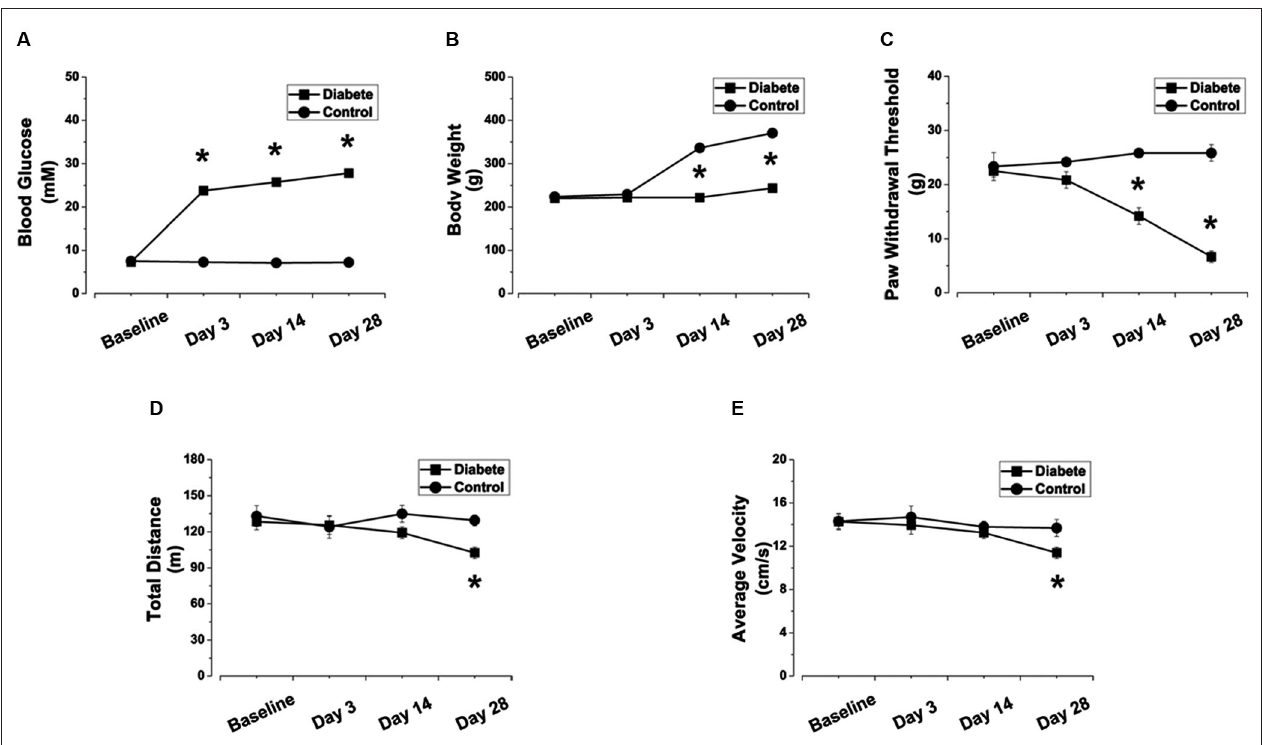
body weight (B) , PWT (C) , total distance (D) and average velocity (E) in STZ-induced diabetic rats. Mean ± SD, n = 6–18 rats in each group. * P < 0.05, comparing diabetic rats with non-diabetic control